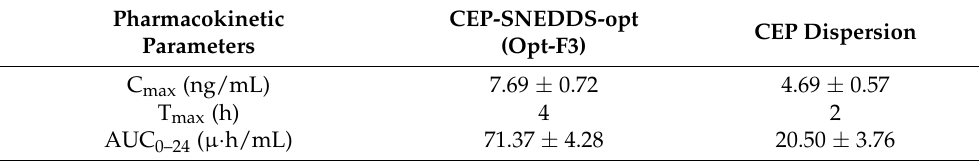
Table 5. Pharmacokinetic parameters of CEP-SNEDDS (Opt-F3) and CEP dispersion after single-dose oral administration. The study performed with six rats in each group and data given as mean ± SD.